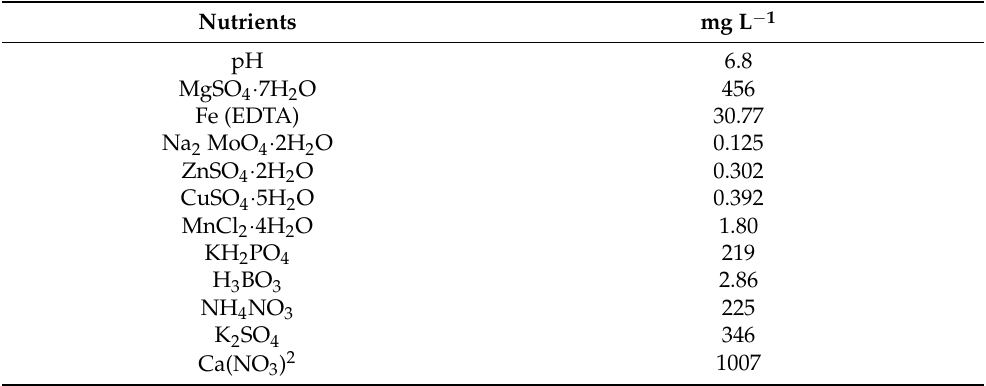
Table 2. Chemical composition and concentration of the nutrient solution used in the nutrient film technique system for lettuce